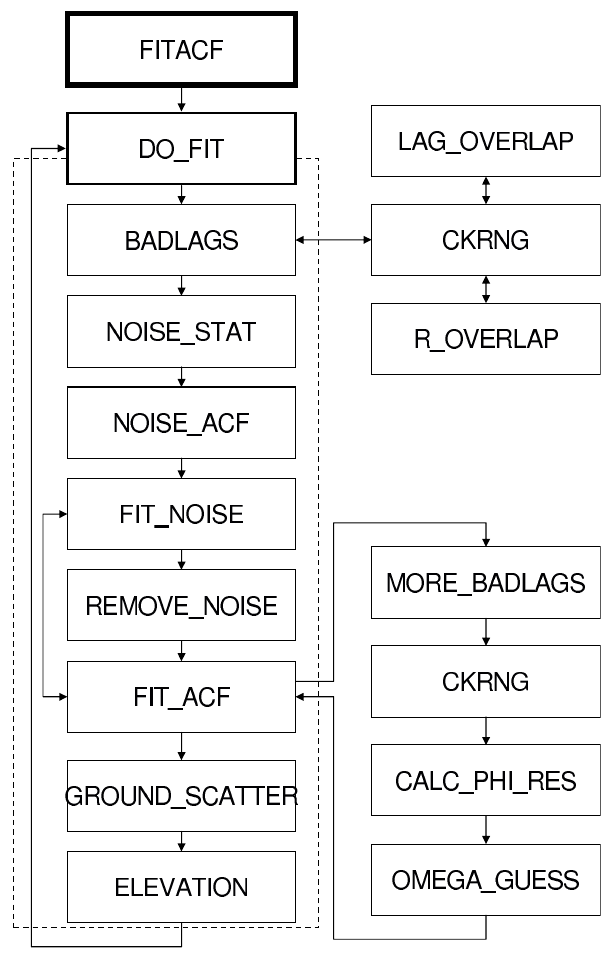
Fig. A1. Flow chart of FITACF